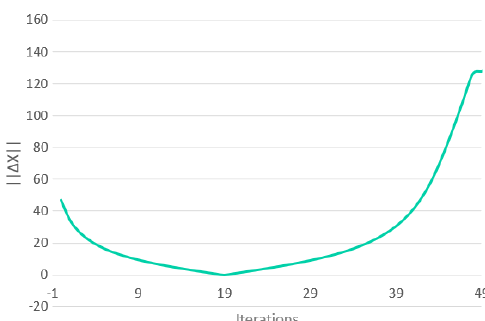
Figure 20: Iteration and time comparison for h = 1.32 r .